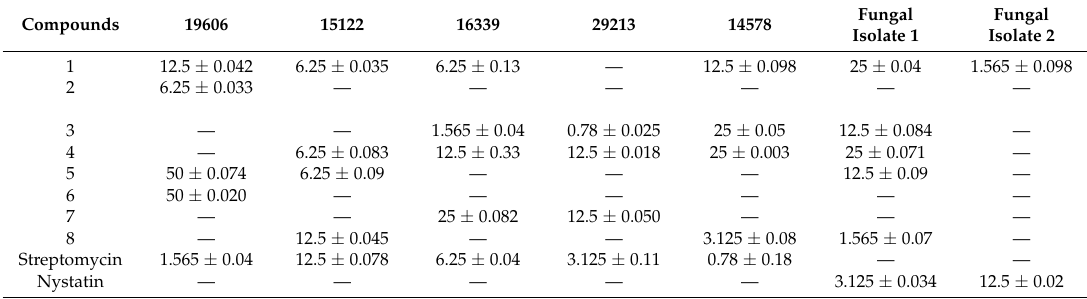
Table 3. Minimum inhibitory concentration of purified compounds from Aspergillus fumigatus SCSIO 41012.